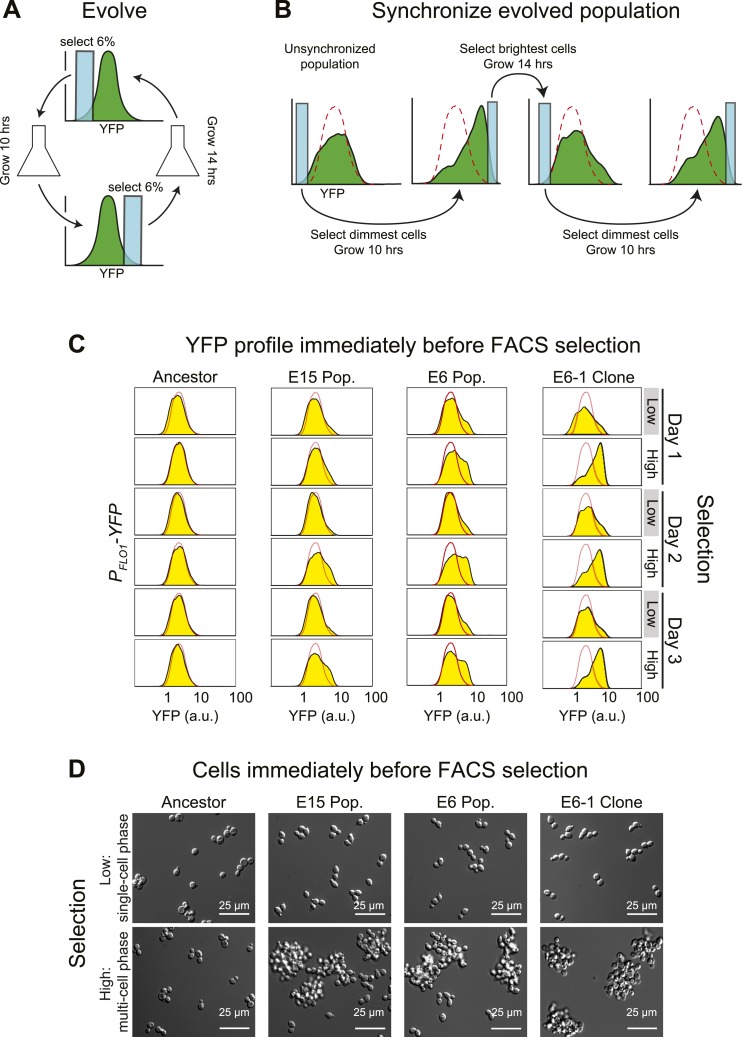
Cell association clock evolves from selecting for high and low YFP expression.(A) Selection scheme for a 24-hr oscillator: cells were collected from the dimmest 6% (E6) of the distribution of YFP fluorescing events, grown exponentially at <1 × 106 cells/ml for ∼10 hr and then the brightest 6% of events were collected and the cells in this population were grown for ∼14 hr at <1 × 106 cells/ml. The selection cycle was repeated for 30 days. The E15 population was evolved in the same manner, but the dimmest and brightest 15% of events were collected in the two phases of the selection. (B) Scheme for synchronizing YFP oscillations from an unsynchronized population: the dimmest events from an unsynchronized population (blue box) are collected, thus selecting for cells at the single cell phase of the oscillation. After 10 hr of growth, distributions are first recorded and the brightest YFP events (clump of cells) are collected, grown for 14 hr, distributions are recorded again and the dimmest events are selected to complete the cycle. This cycle is repeated to keep the population maximally synchronized. The dashed red lines represent the fluorescence distribution of the ancestral population. (C) Representative density plots showing oscillations in YFP fluorescence of a FACS-synchronized sample of the E6 and E15 populations after terminating the selection, and a clone isolated from E6 (E6-1). The red outline overlay shows the average ancestral distribution. (D) Representative DIC images of synchronized populations immediately before FACS selection for low (single-cell phase) and high (multi-cell phase) YFP fluorescence.